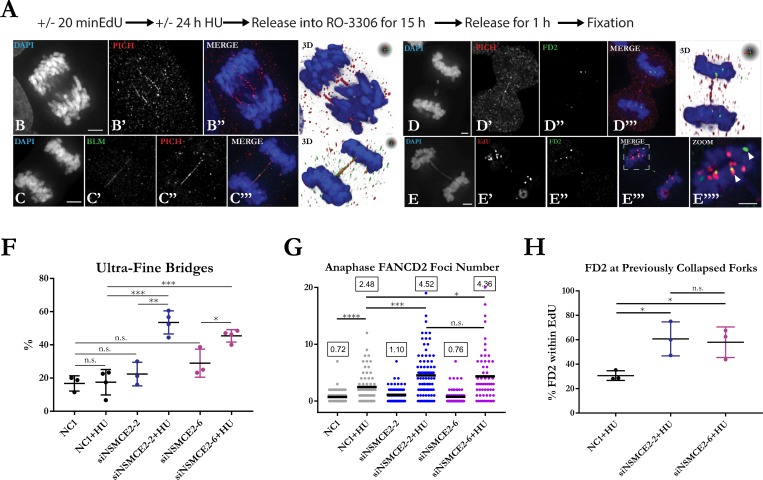
NSMCE2 prevents mitosis-dependent DNA damage.(A) Schematic for treatment and enrichment of anaphase cells for analysis of UFBs and FANCD2 foci. (B) Representative deconvoluted, maximum intensity projection images of z-stacks showing multiple PICH positive UFBs, (C) BLM/PICH colocalization, (D) FANCD2 foci flanking UFBs, and (E) EdU/FANCD2 co-localization in anaphase cells. Scale bars represent 5 microns. (F) Quantitative analysis of PICH-stained UFBs in NSMCE2-deficient and control cells, processed as in A. 30–50 anaphase z-stacks were analyzed in each experimental condition. At least three independent experiments were performed. (G) Quantitation of number of FANCD2 foci per cell in anaphase cells independent of UFBs. 30–50 anaphase z-stacks were analyzed in each experimental condition. (H) Quantitation of EdU positive anaphase cells represented as the percent of FANCD2 foci localized in regions with EdU signal. At least 100 FANCD2 foci were analyzed in each experiment in cells positive for EdU signal only. Mean and standard deviation is shown. Three independent experiments were performed. See Fig 1 for definition of asterisks.